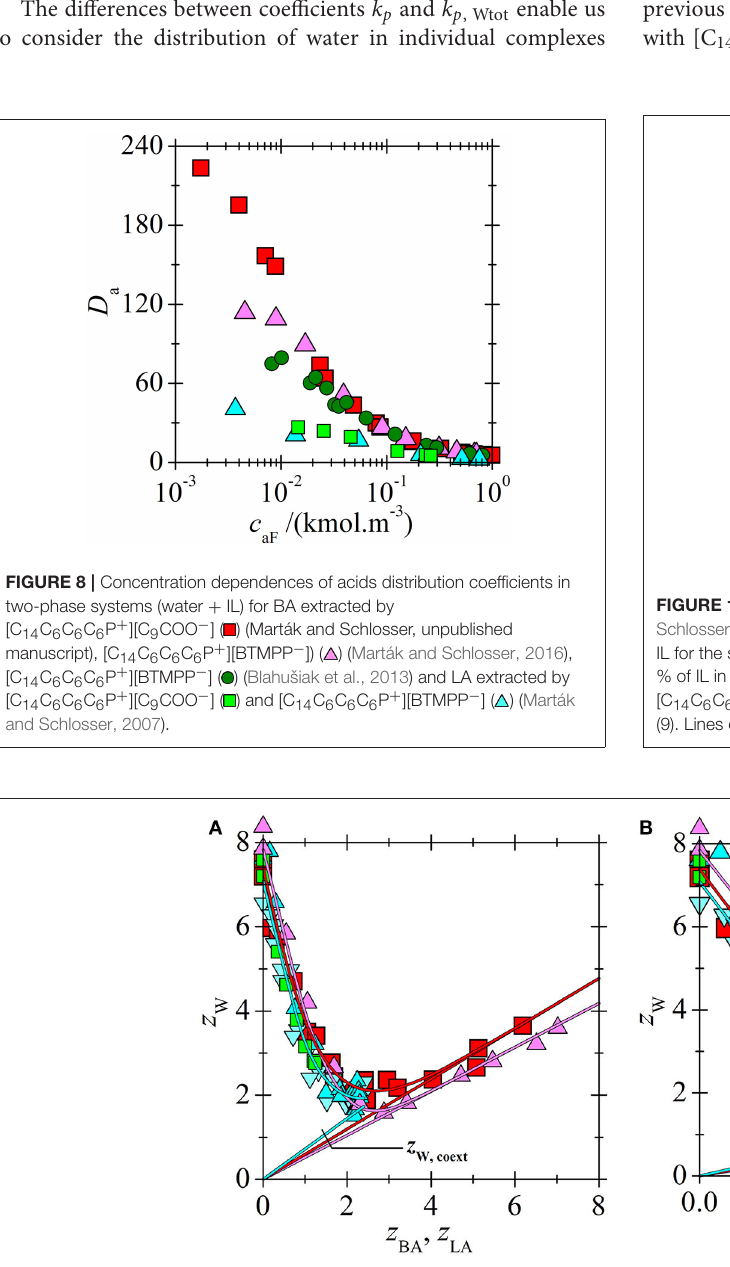
Frontiers in Chemistry |